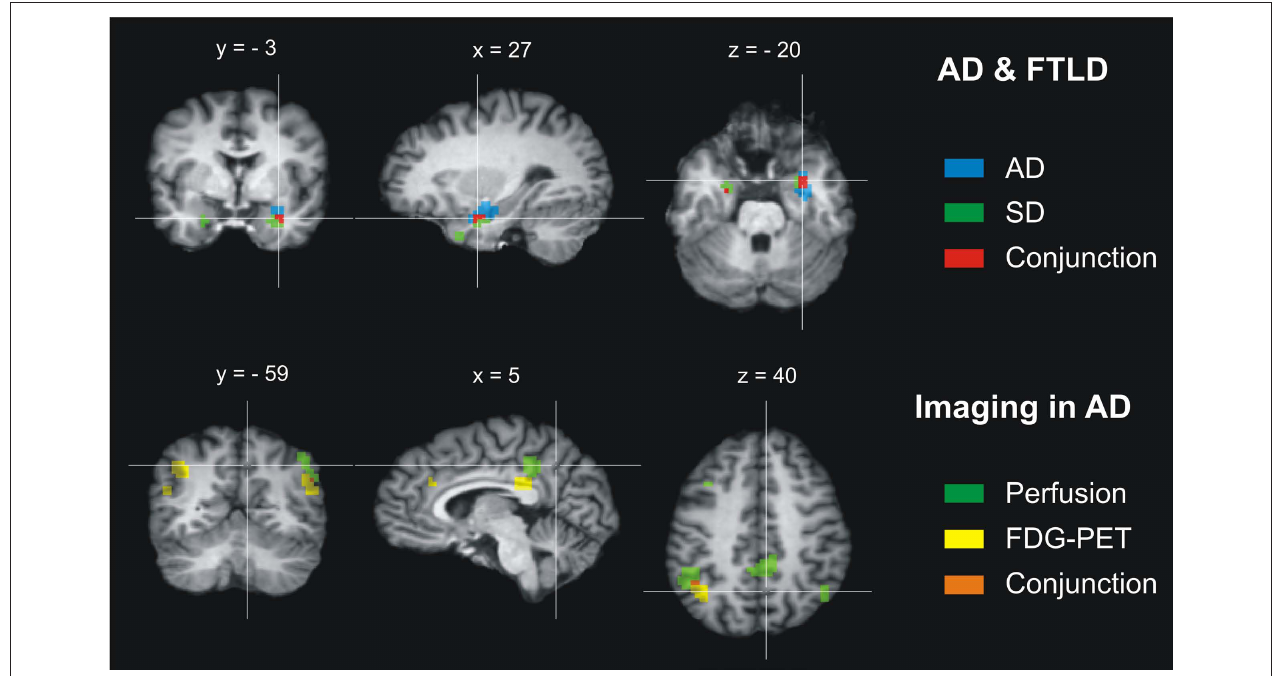
subtypes. Lower row : Abnormally low perfusion and glucose utilization overlap in AD in both angular and supramarginal gyri (left − 47 − 52 40/135 mm 3 , right 49 − 58 31/27 mm 3 ) and affect tightly adjoining brain regions in the inferior precuneus and posterior cingulate cortex, whereas atrophy was regionally dissociated from these functional imaging measures. Coordinates in Talairach space. Left